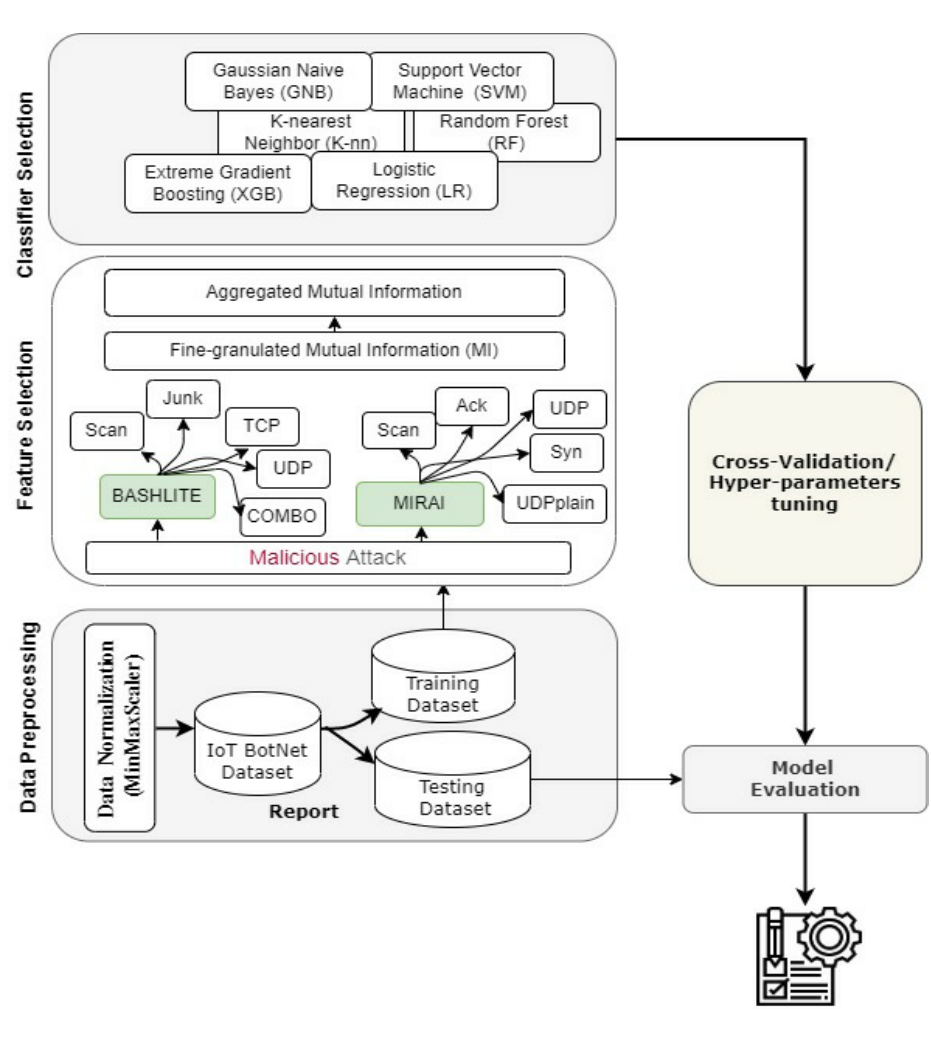
Figure 1. The framework of the proposed approach.